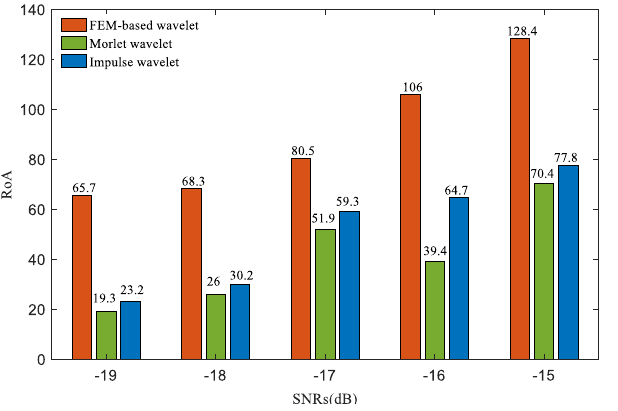
Figure 20. Results of impulse response wavelet on inner ring fault: ( a ) filtered signal; ( b ) the enve- lope spectrum of the filtered signal.